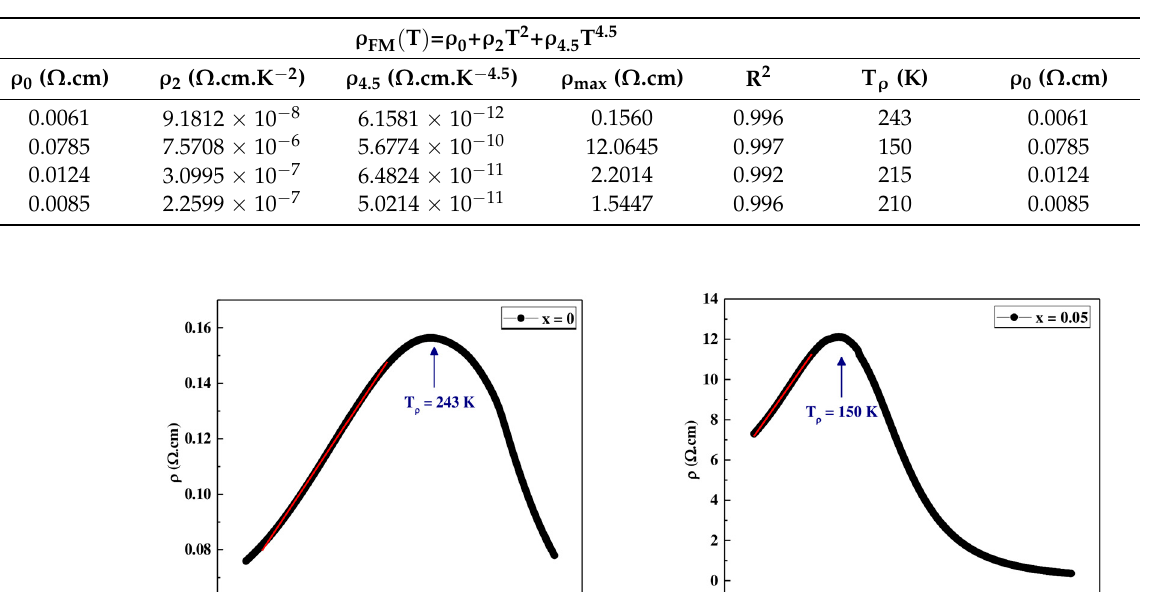
Table 8. Fit parameters to Equation (9) obtained for the metallic behavior (below T ρ ) for